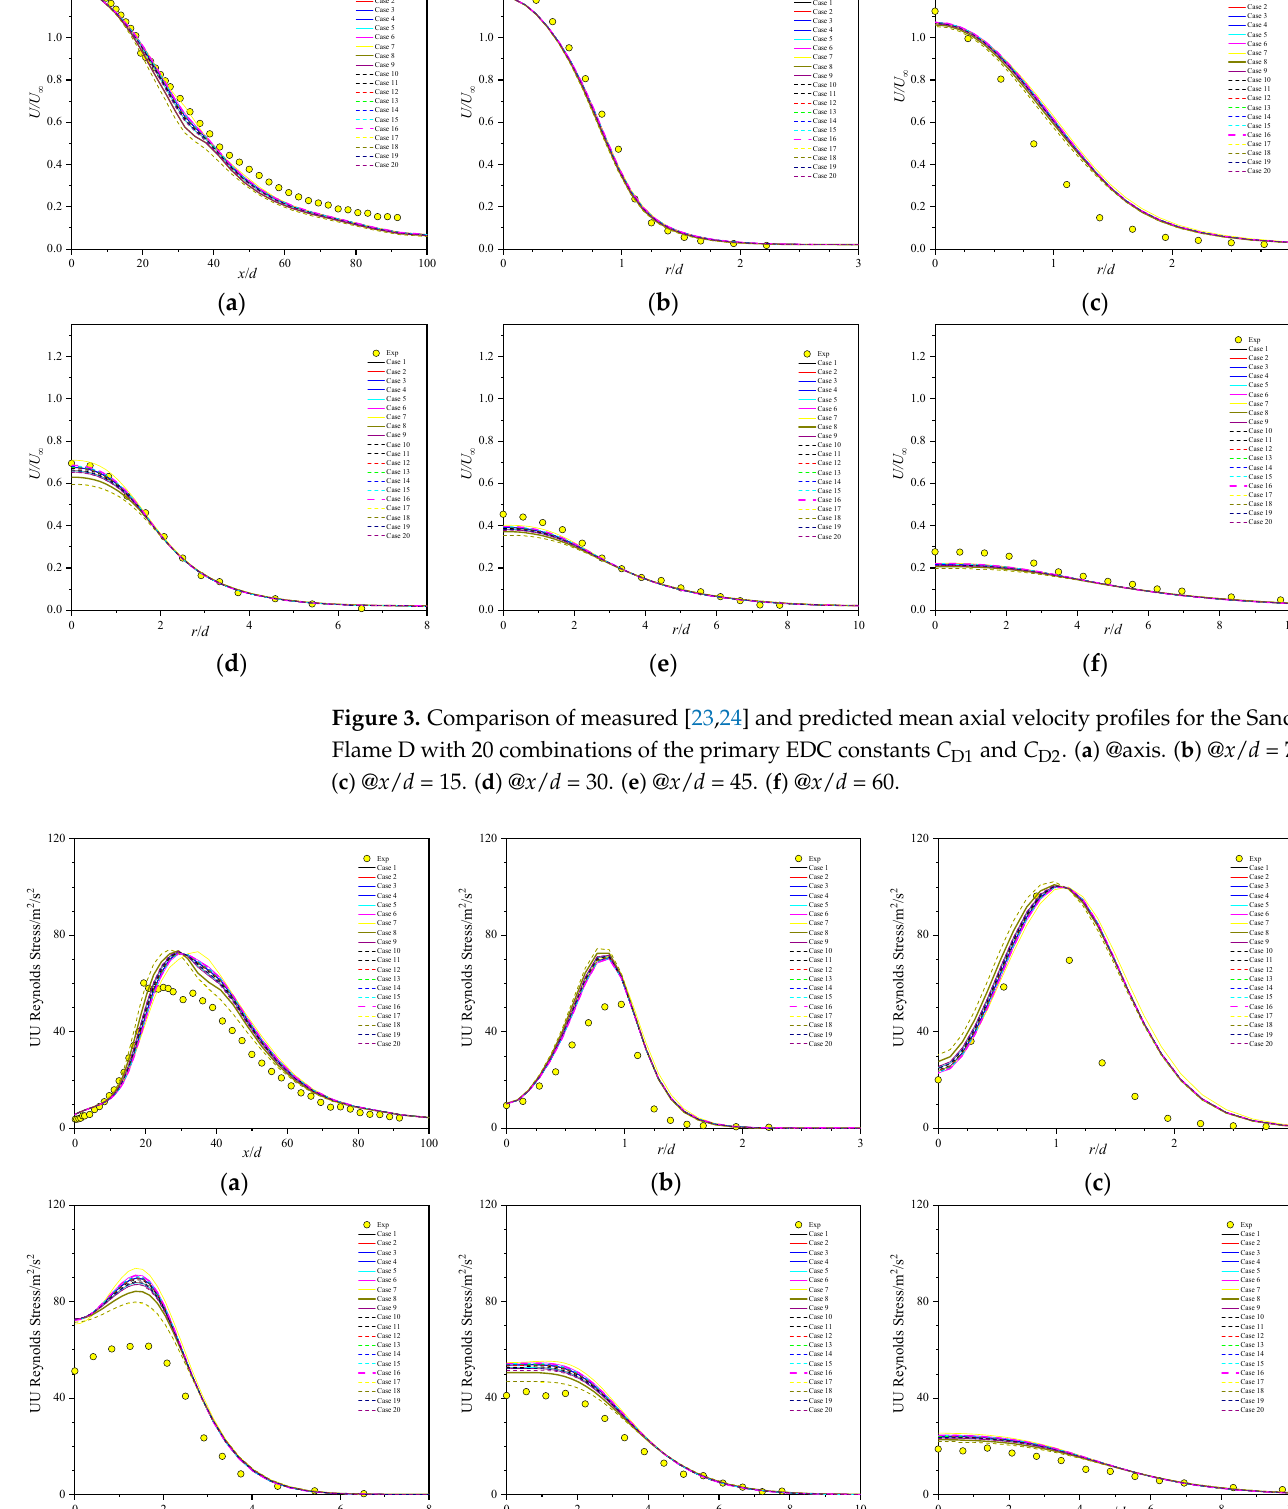
Figure 4. Comparison of measured [23,24] and predicted UU Reynolds normal stress profiles for the Sandia Flame D with 20 combinations of the primary EDC constants 𝐶 (cid:2888)(cid:2869) and 𝐶 (cid:2888)(cid:2870) . ( a ) @axis. ( b ) @ x / d = 7.5. ( c ) @ x / d = 15. ( d ) @ x / d = 30. ( e ) @ x / d = 45. ( f ) @ x / d =